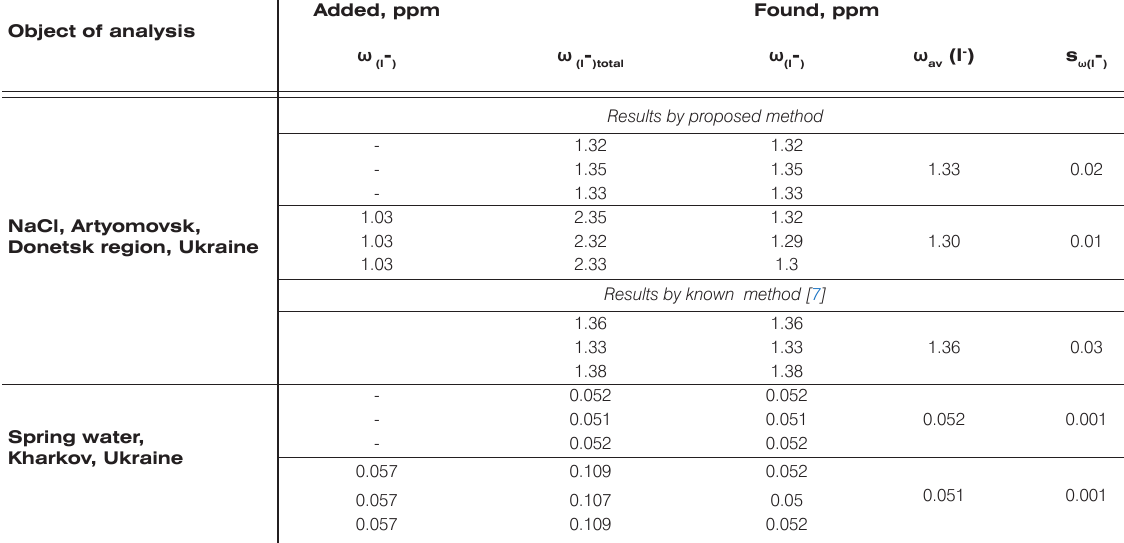
- standard deviation of mass fraction). ω